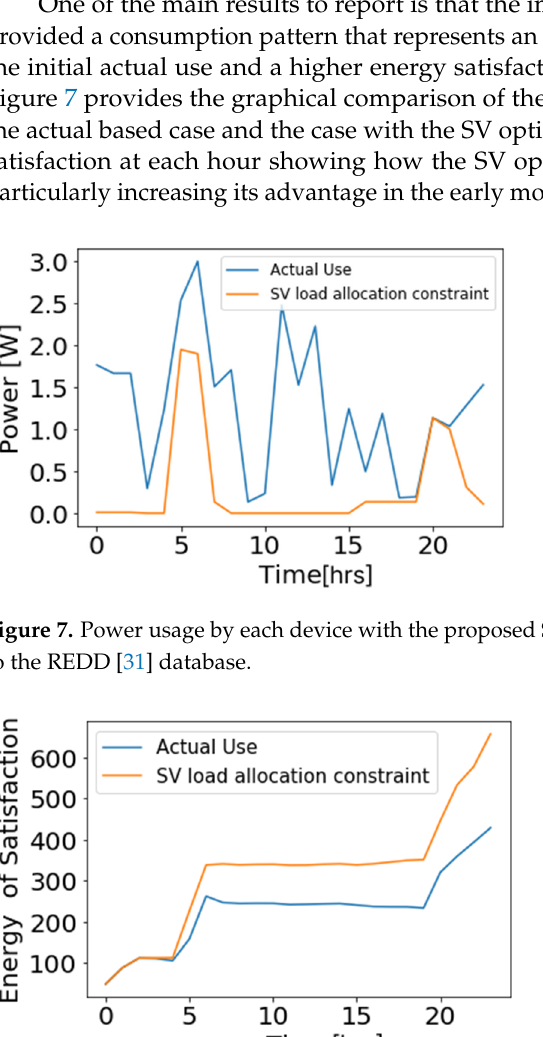
Figure 9. Power usage by each device with the proposed SV load allocations (left side) vs. real usage according to the REDD (right side) [31] database.